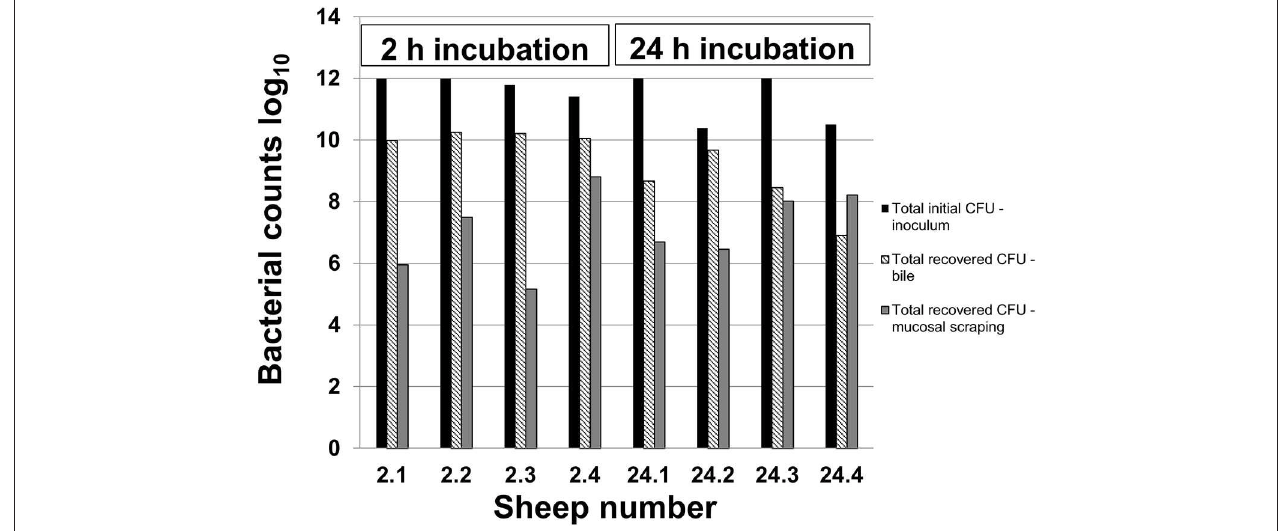
FIGURE 1 | Recovery of C. jejuni in bile and mucosal scrapings following inoculation. Samples of bile and mucosal scrapings following 2 and 24h incubation of C. jejuni inoculated directly into the ovine gallbladder were cultured to estimate total remaining CFU using serial dilutions and the drop plate method of enumeration.